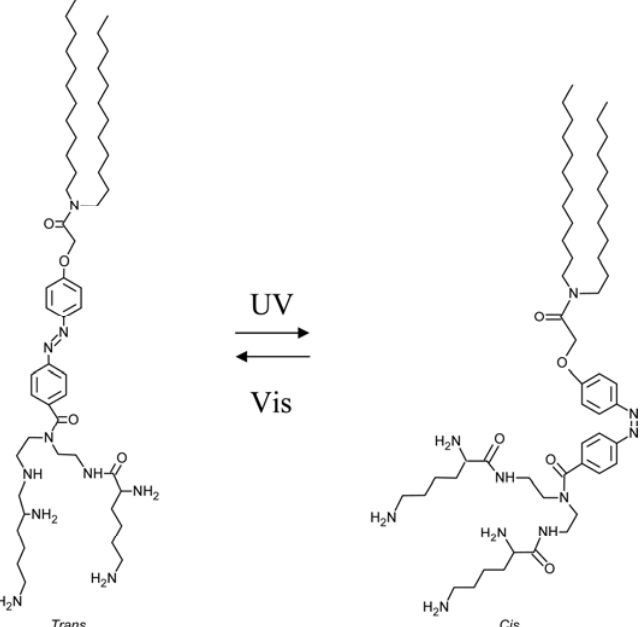
Figure 42. Chemical formula of